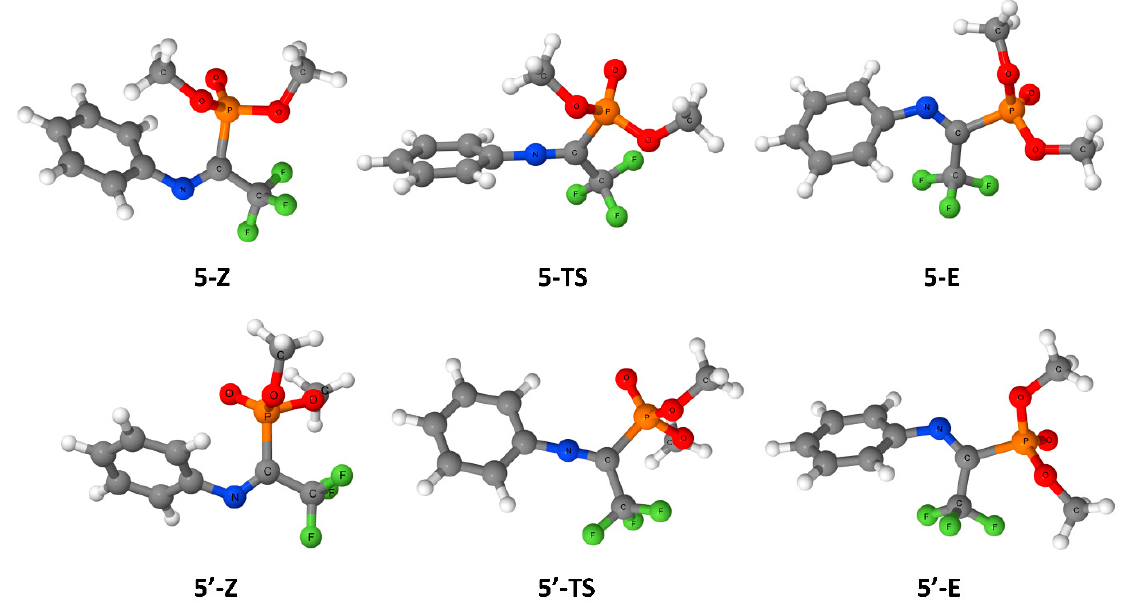
Figure 9. Optimized structures of the Z- and E-isomers of compound 5 ( 5-Z , 5 ′ -Z and 5-E , 5 ′ -E , respectively), and the structures corresponding to the transition states of the isomerization reaction ( 5-TS and 5 ′ -TS ).